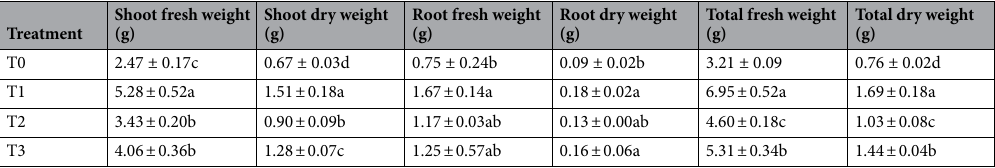
Table 5. Effects of the mixture of rice husk ash and red soil with various proportions on fresh (dry) weight of cotton seedlings.